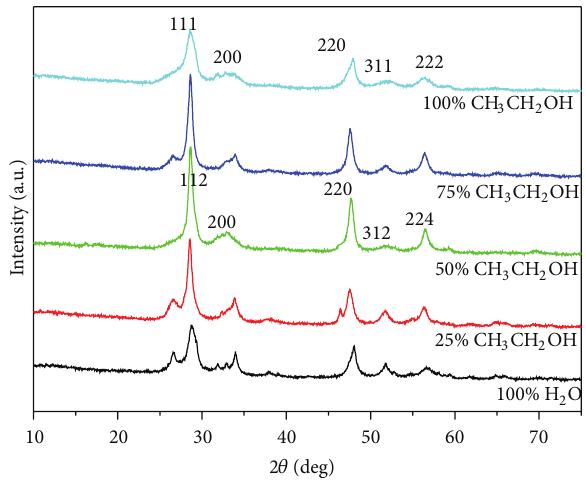
Figure 2: XRD spectra of the obtained samples at 200 ∘ C for 7.5h as the function of different ethanol contents.